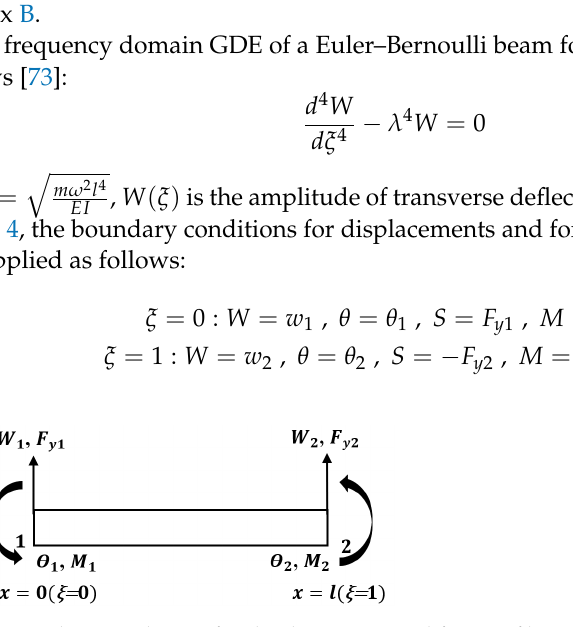
Figure 4. Boundary conditions for displacements and forces of bending